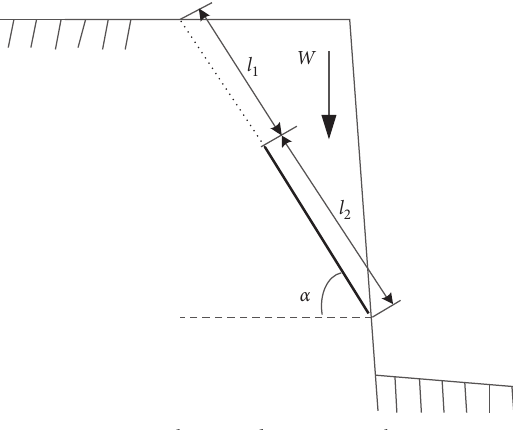
Figure 1: Slip-type dangerous rock